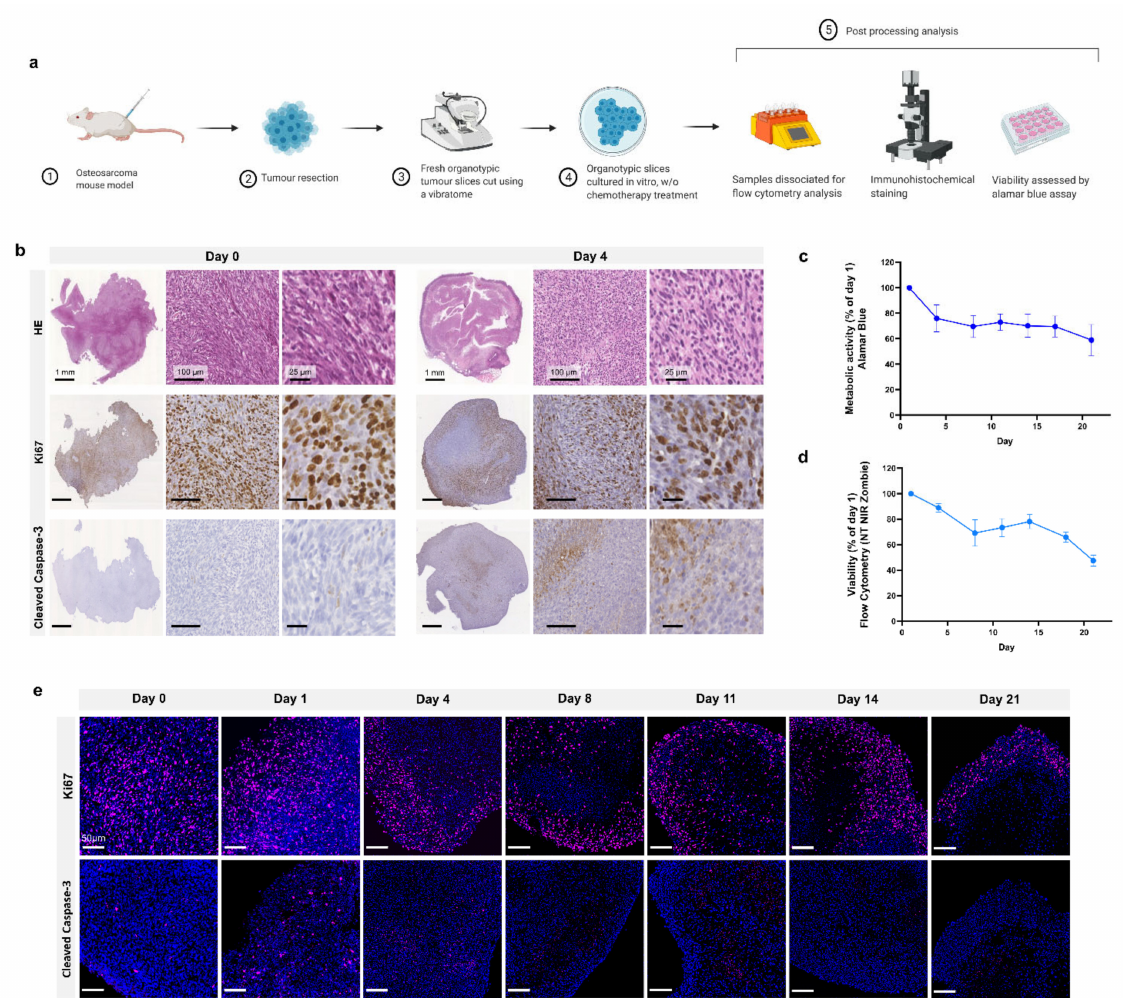
Figure 1. Organotypic culture. ( a ) Project workflow. Mice are injected with MosJ osteosarcoma cells; when desired mass is reached, mice are sacrificed, and the tumour is resected. Tumour slices are cut using a vibratome and cultured with/without chemotherapy treatments. Organotypic slices are fixed for immunohistochemical staining, dissociated for flow cytometry analysis, or assessed by Alamar blue assay. ( b ) 5 µ m slices of fixed paraffin embedded organotypic sections from day 0 and day 4 are stained with H&E, Ki67, and cleaved caspase-3. ( c ) Metabolic activity and ( d ) cell viability of organotypic slices were measured for 21 days (Day 1, 4, 8, 11, 14, 17 and 21) and normalised to day 1; data is expressed as Mean ± SD of n = 6 samples and n = 3 samples, respectively. ( e ) Fluorescent microscopy on 5 µ m slices of fixed paraffin embedded organotypic sections from day 0 to day 21. Samples are labelled with Ki67 (cell proliferation, pink) or cleaved caspase-3 (apoptosis, pink), and DAPI (nuclei,